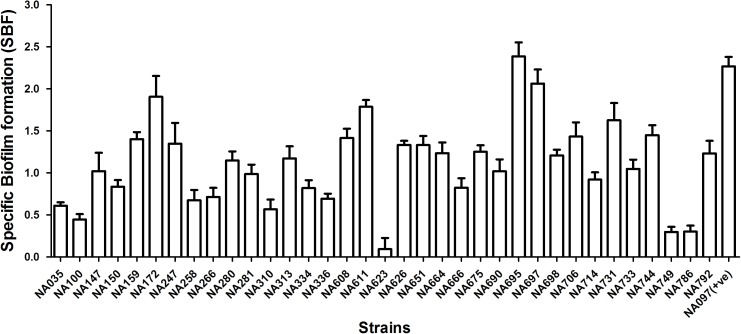
Biofilm formation in 35 pks positive E. coli isolates in M63 medium. Values are shown as mean of specific biofilm formation. Isolates demonstrating SBF values > 1.0 were considered as strong, 0.5–1.0 as moderate and <0.5 as weak biofilm formers. Majority of isolates (21/35) demonstrated strong biofilm formation; the remaining 10 and 4 isolates showed moderate and weak biofilm formation, respectively. NA097 was employed as a positive control in the biofilm formation assay.